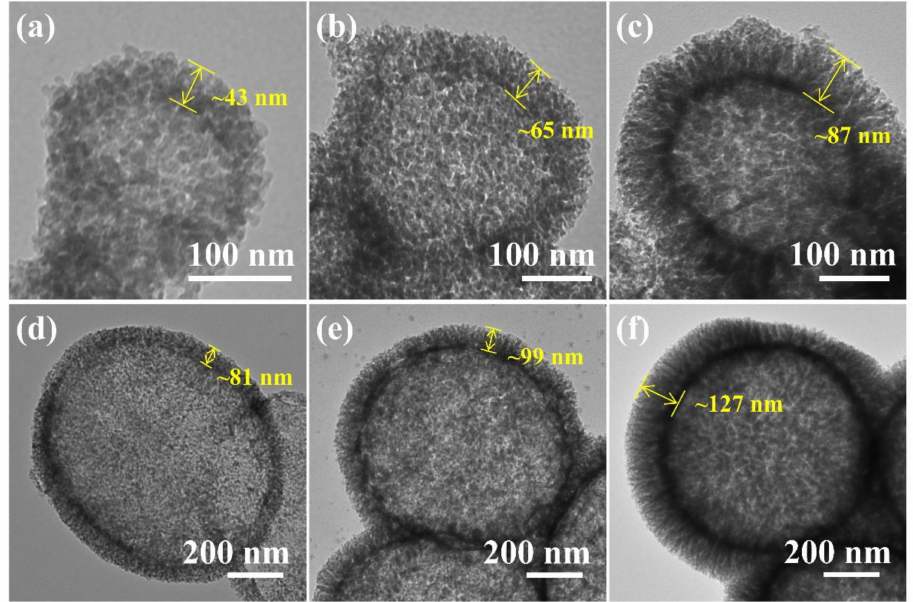
Figure 6. TEM images of HMSNs synthesized with BaSO 4 NP-S ( a – c ) and BaSO 4 NP-L ( d – f ) as the sacrificial template. The amount of TEOS added in the synthesis was 0.545 mL ( a , d ), 1.095 mL ( b , e ), and 2.190 mL ( c , f ),